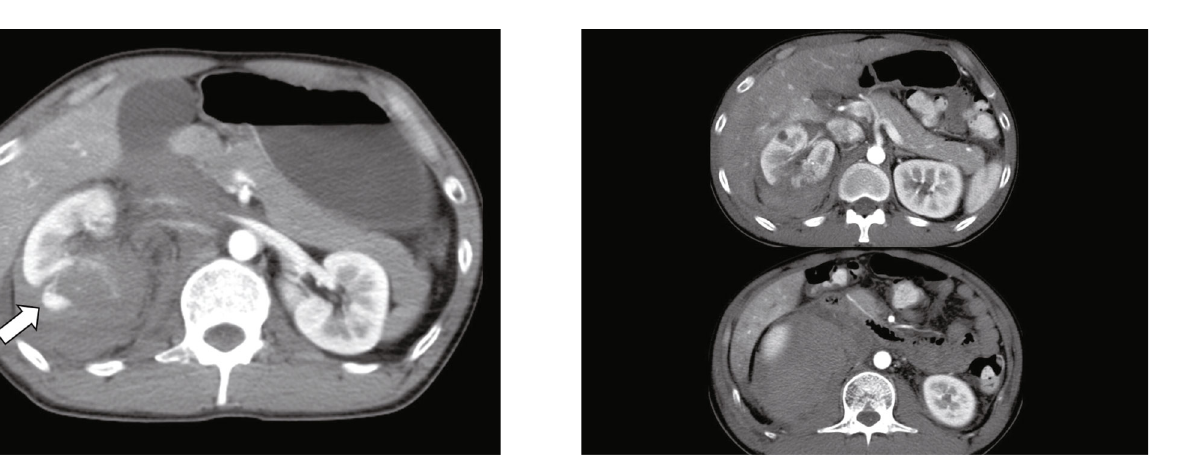
Figure 2: Enhanced abdominal computed tomography (CT) on hospital day 5. CT showed no exudative in fl ammation around the pancreas, which had been moved upward by the retroperitoneal